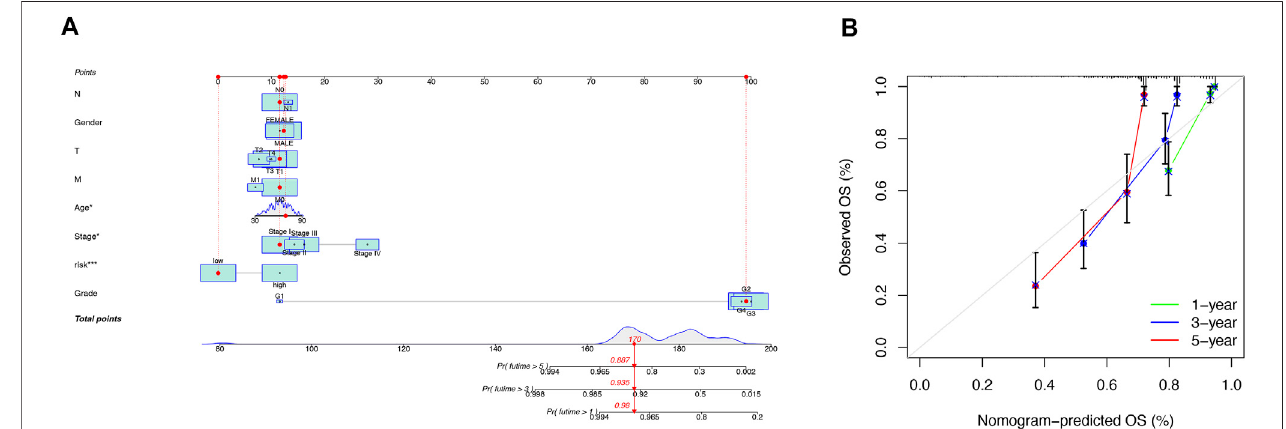
FIGURE5| Constructionandvalidationofthenomogram.Anomogramcombiningclinicopathologicalvariablesandriskscorespredicts1-,3-,and5-yearsoverall survival in patients with ccRCC (A) . Calibration curves test the agreement between actual and predicted outcomes at 1, 3, and 5 years (B) .